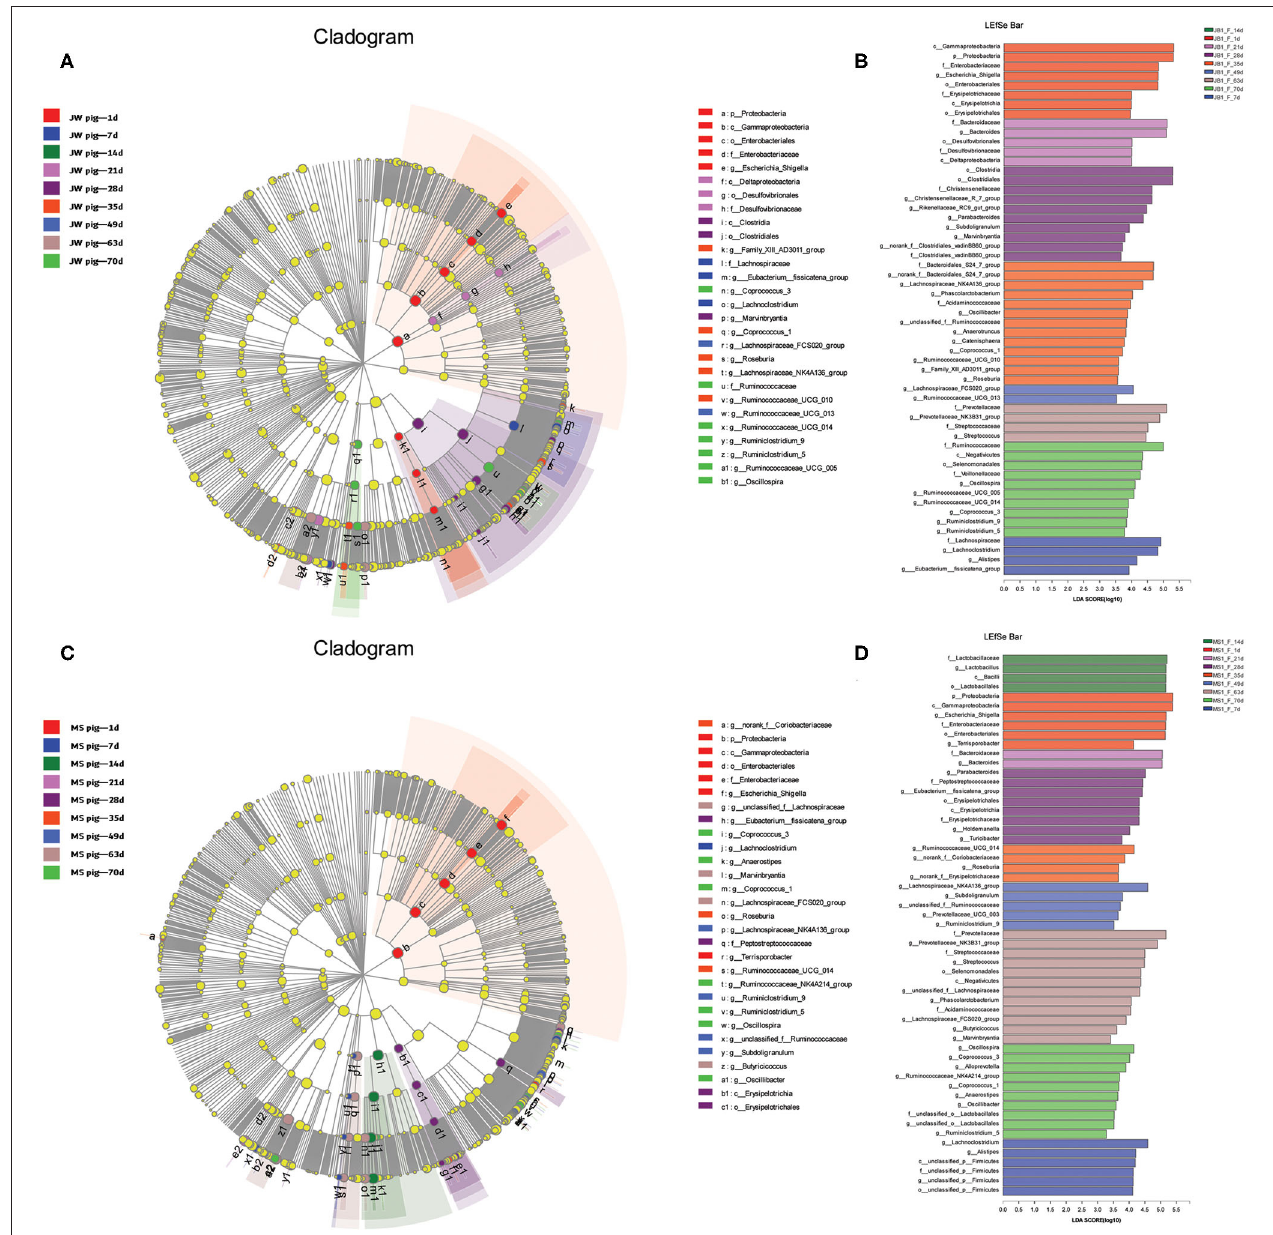
FIGURE 5 | Beta diversity of bacterial communities in feces of piglets at different development stages. (A,B) Linear discriminatory analyses (LEfSe) of bacterial taxa in Jinfen White piglets (LDA > 3). (C,D) Linear discriminatory analyses (LEfSe) of bacterial taxa in Mashen piglets (LDA > 3).